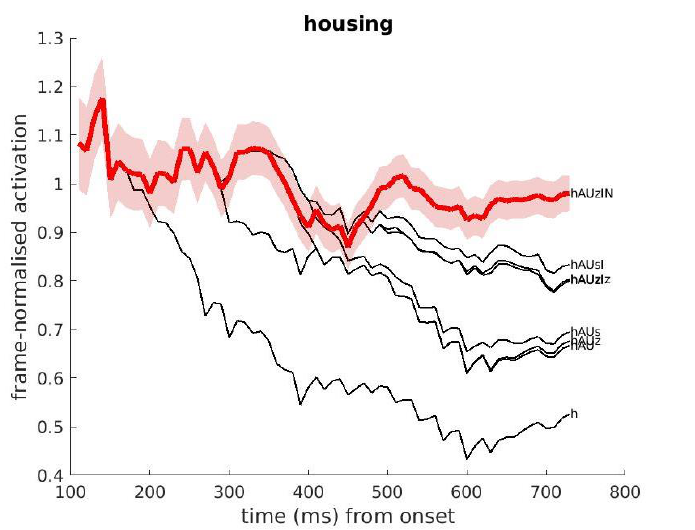
Figure 3. Example of DIANA’s activation over time corresponding to the input English word ‘housing’. The figure shows the activations of the competing words ‘housing’ and ‘houses’, and their word starts (cohorts). The red line shows the evolution of the winning candidate over time. The pink band around the red line indicates the p = 0.05 confidence interval. The competing forms are denoted (using SAMPA) at the right-hand side of each plot. A few competitors almost overlap with each other until stimulus offset.